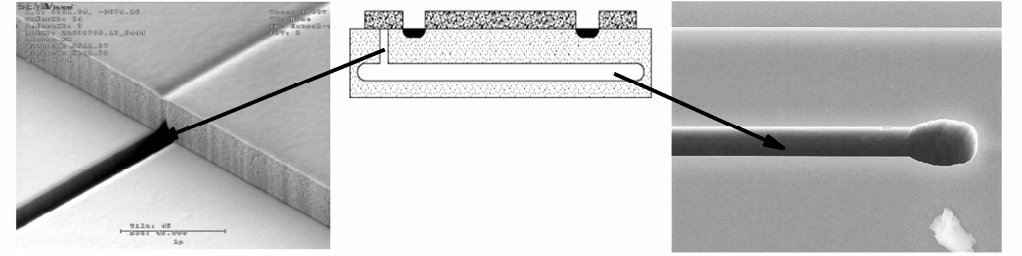
Figure 2. Sacrificial layer over deep trench and SON